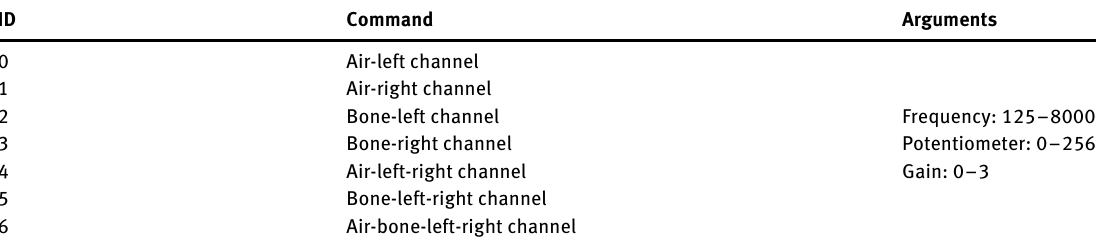
Table 1: List of commands that the smartphone can send to the device.